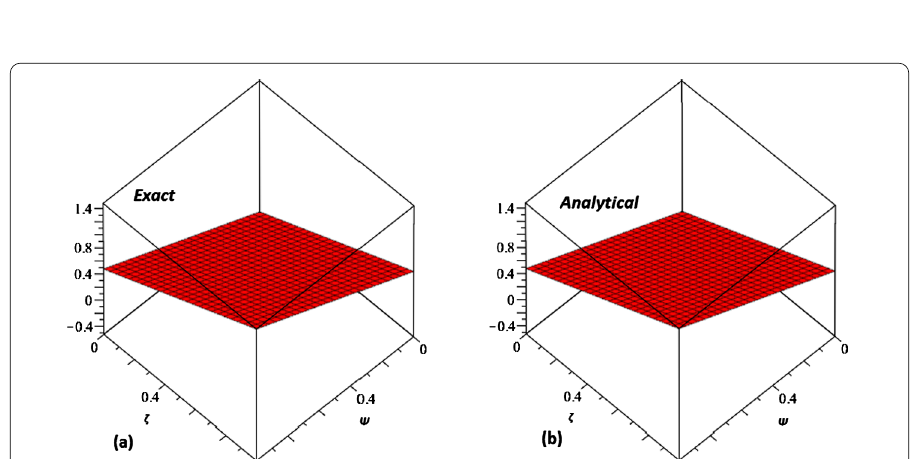
Figure 10 The ν -solution graph of example 3, ( a ) exact solution and ( b ) ETDM solution at δ = 1